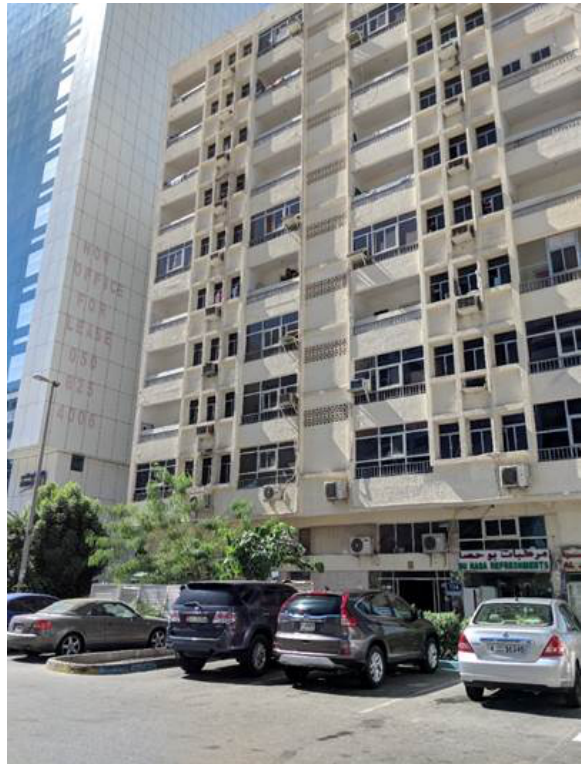
Figure 1 The case study area (Source: author).